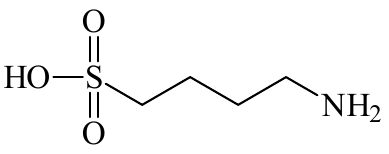
Figure 7. Structure of homotaurine (tamiprosate, Alzehmed™).